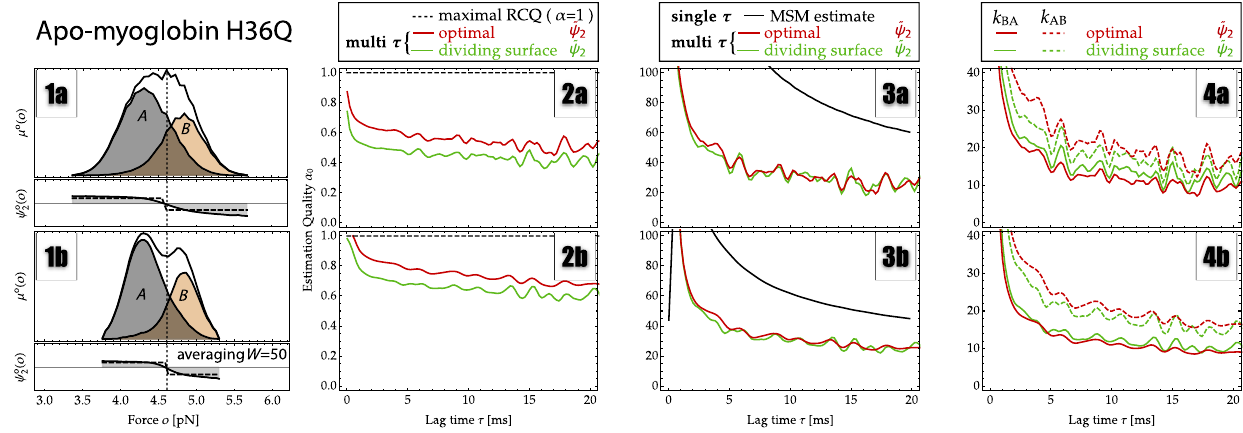
FIG. 5. Estimates for rates and estimation qualities from passive-mode single-molecule force-probe experiments of apo-myoglobin. All panels report the estimation results, showing the direct Markov model estimate (black line), a fit to the fluctuation autocorrelation function using a dividing surface at the histogram maximum (minimum between two maxima for filtering) o ¼ 4 . 6 pN (green line), and spectral estimation (red line). (1a),(1b) The stationary probability of observing a given force value (solid black line). The partial probabilities of states A (gray) and B (orange) obtained by spectral estimation show that there is very little overlap between the states. (2a),(2b) The estimation quality α o , coinciding with the OQ ˆ α o , for spectral estimation. (3a),(3b) Estimated relaxation rate κ 2 . (4a),(4b) Estimated microscopic transition rates k AB (dashed line) and k BA (solid